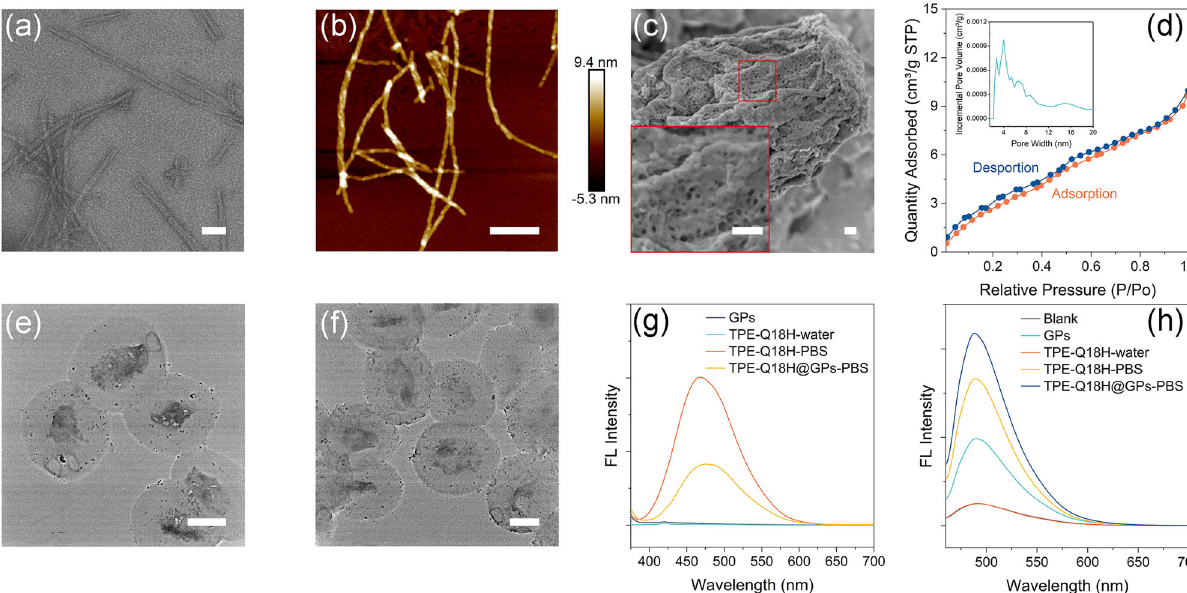
Fig. 2 Characterization of TPE-Q18H, GPs, and TPE-Q18H@GPs. a TEM image of TPE-Q18H nano fi bers. Scale bar: 50 nm. b AFM image of TPE-Q18H nano fi bers. Scale bar: 200 nm. c SEM image and locally enlarged view of GPs. Scale bar: 100 nm. d Nitrogen adsorption isotherms and pore size distribution (inset) calculated based on DFT method for GPs. e TEM images of GPs and f TEM images of TPE-Q18H@GPs. Scale bar: 2 μ m. g Fluorescence spectra of TPE-Q18H, GPs, and TPE-Q18H@GPs. λ ex = 365 nm. h Fluorescence spectra of thio fl avin T in presence of TPE-Q18H, GPs, and TPE-Q18H@GPs. λ = 440 nm. TPE-Q18H: 90 μ g/mL; GPs: 1 mg/mL; TPE-Q18H@GPs: 90 μ g/mg/mL; Th T: 100 µ ex